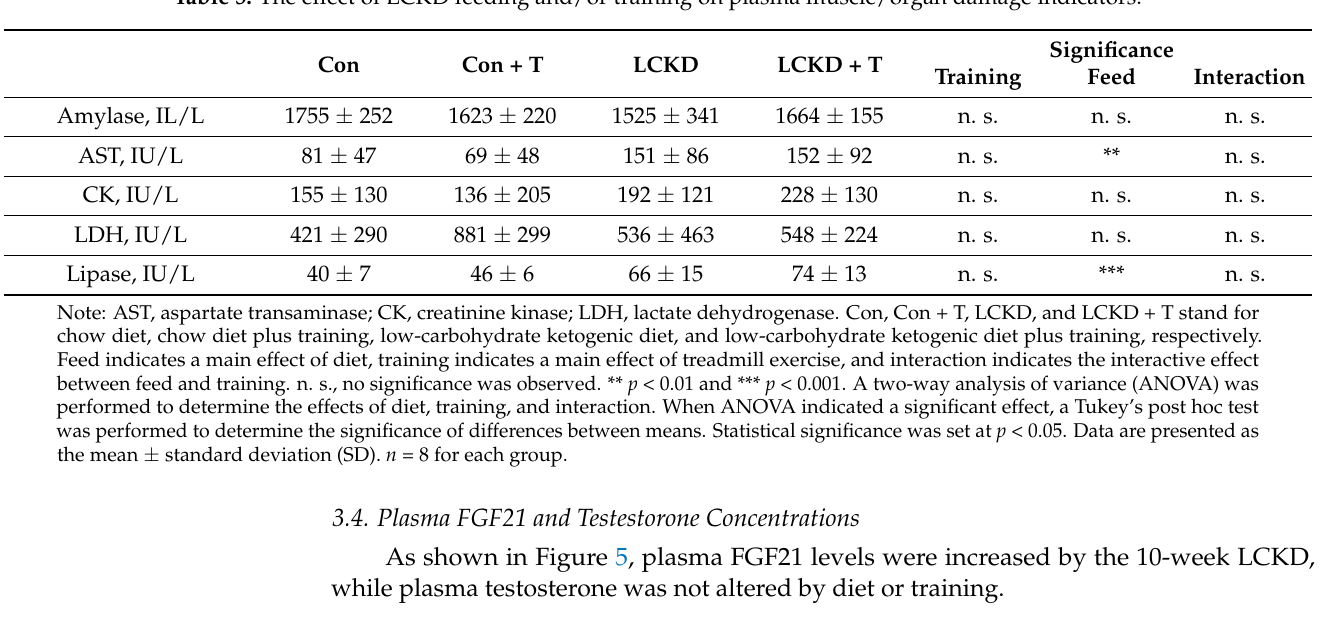
Significance Training Feed